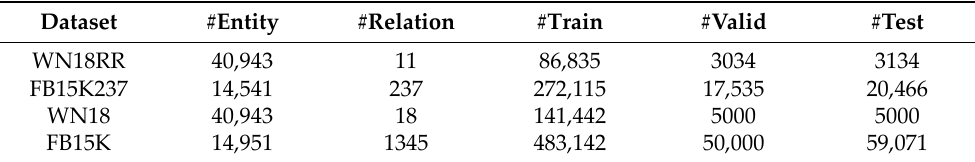
Table 2. Statistics of datasets. The symbols #entity and #relation denote the number of entities and relations, respectively. #train, #valid, and #test denote the size of train set, validation set, and test set, respectively.